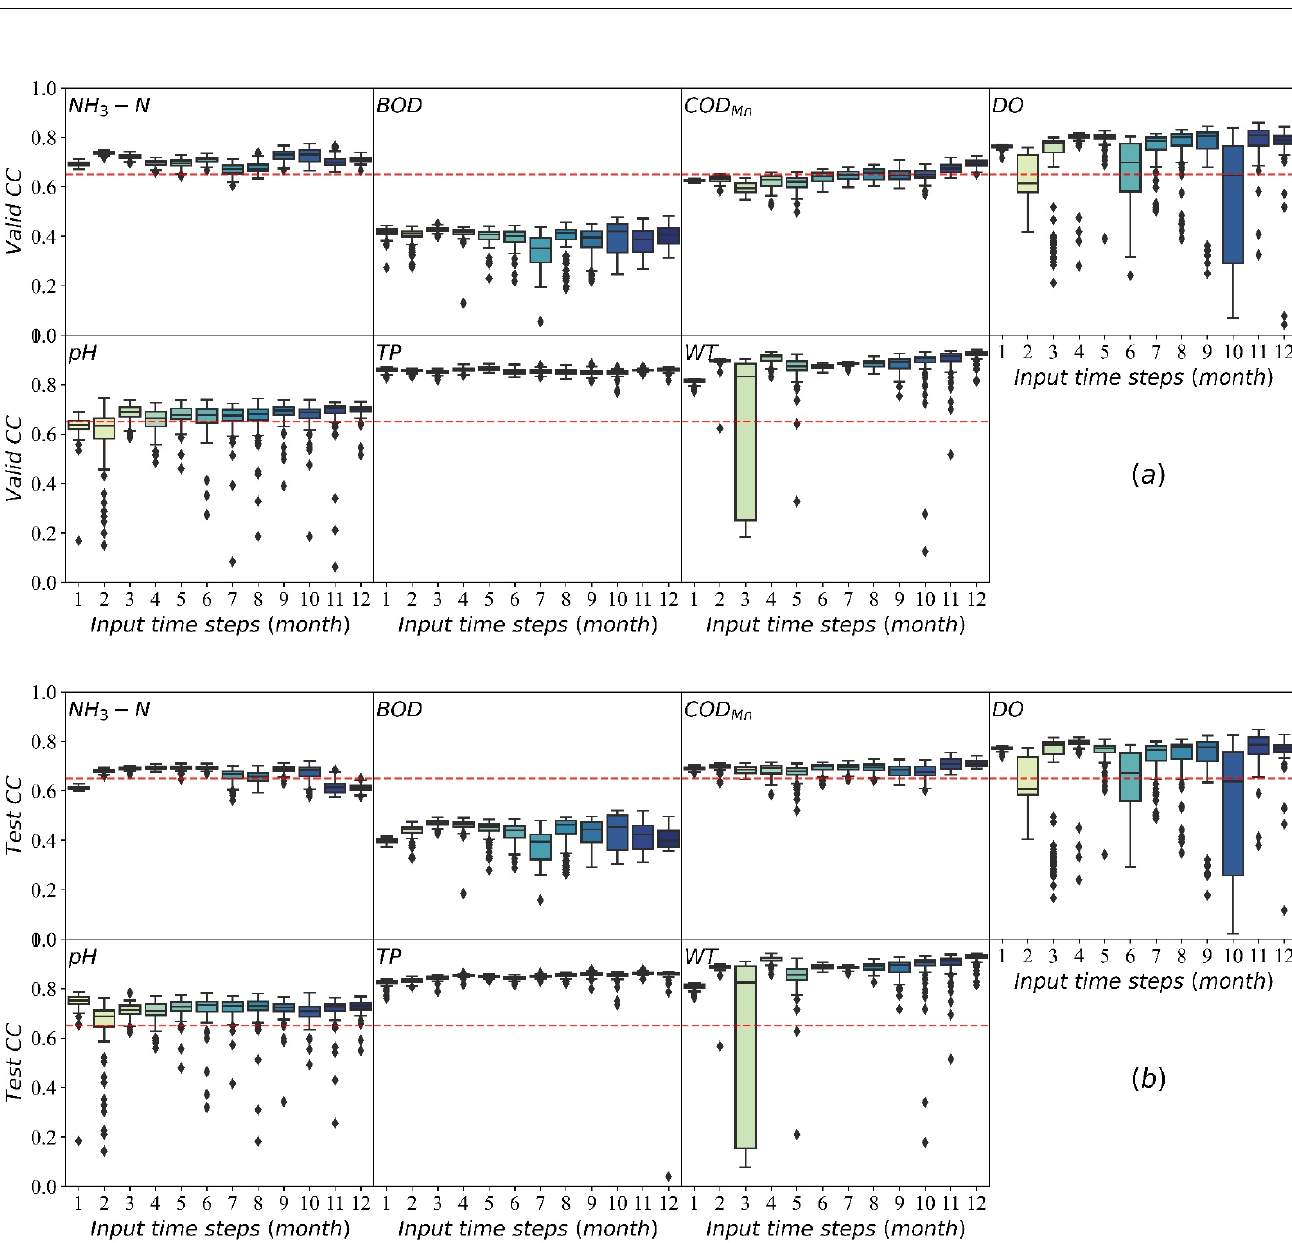
Figure 8. Distribution of cross-correlation ( CC ) values between predicted results and measured values for each water quality indicator predicted results in the the validation set ( a ) and test set ( b ). The lower boundary of the box represents the minimum value. The upper boundary of the box represents the maximum value. The red dotted lines represent the threshold of acceptable model performance ( CC = 0.65).